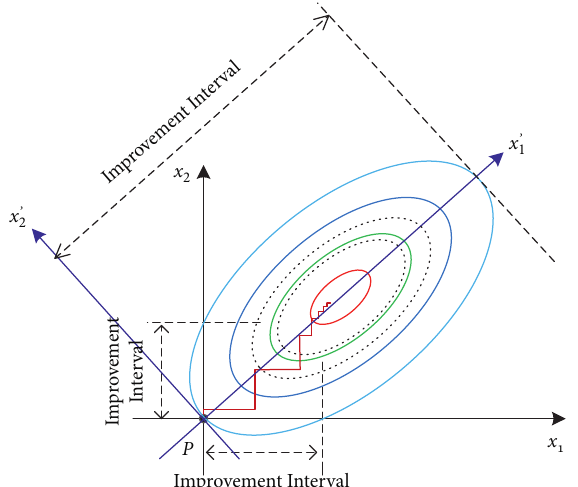
Figure 5: Increasing the improvement interval of variables by turning the coordinate system [52].